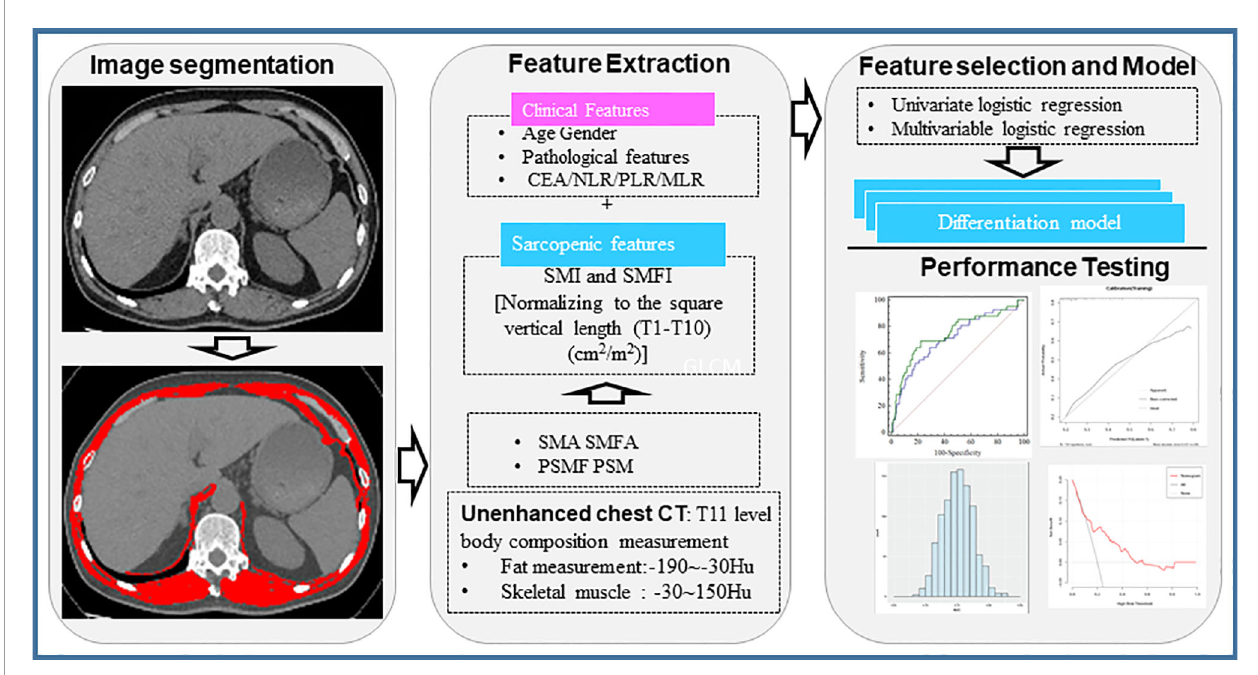
FIGURE 2 | Work fl ow of chest CT image-based evaluation of body composition. CEA, Carcinoembryonic antigen; NLR, Neutrophil to lymphocyte ratio; PLR, Platelet-to-Lymphocyte ratio; MLR, Monocyte to Lymphocyte ratio; SMI, Skeletal muscle index; SMFI, subcutaneous muscle fat index; SMA, skeletal muscle area; SMFA, subcutaneous muscle fat